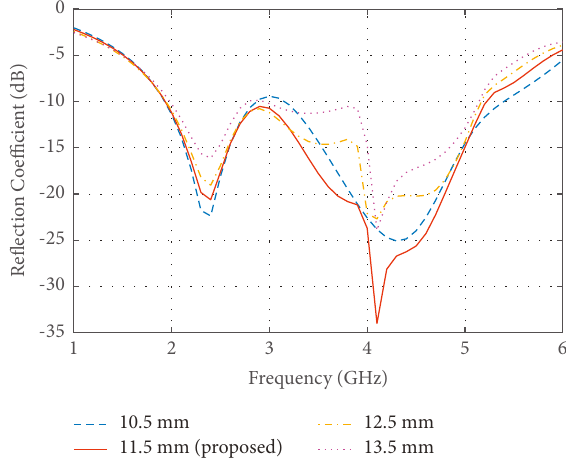
Figure 7: Variation of return loss versus frequency at different values of w [29]. 1